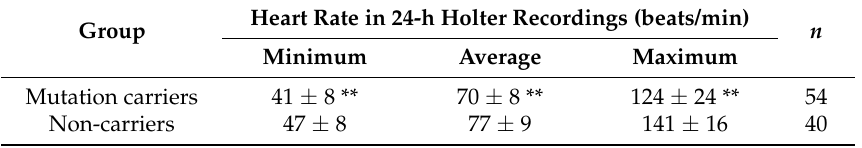
Table 1. Heart rate in carriers of the 1795insD mutation in the SCN5A gene.